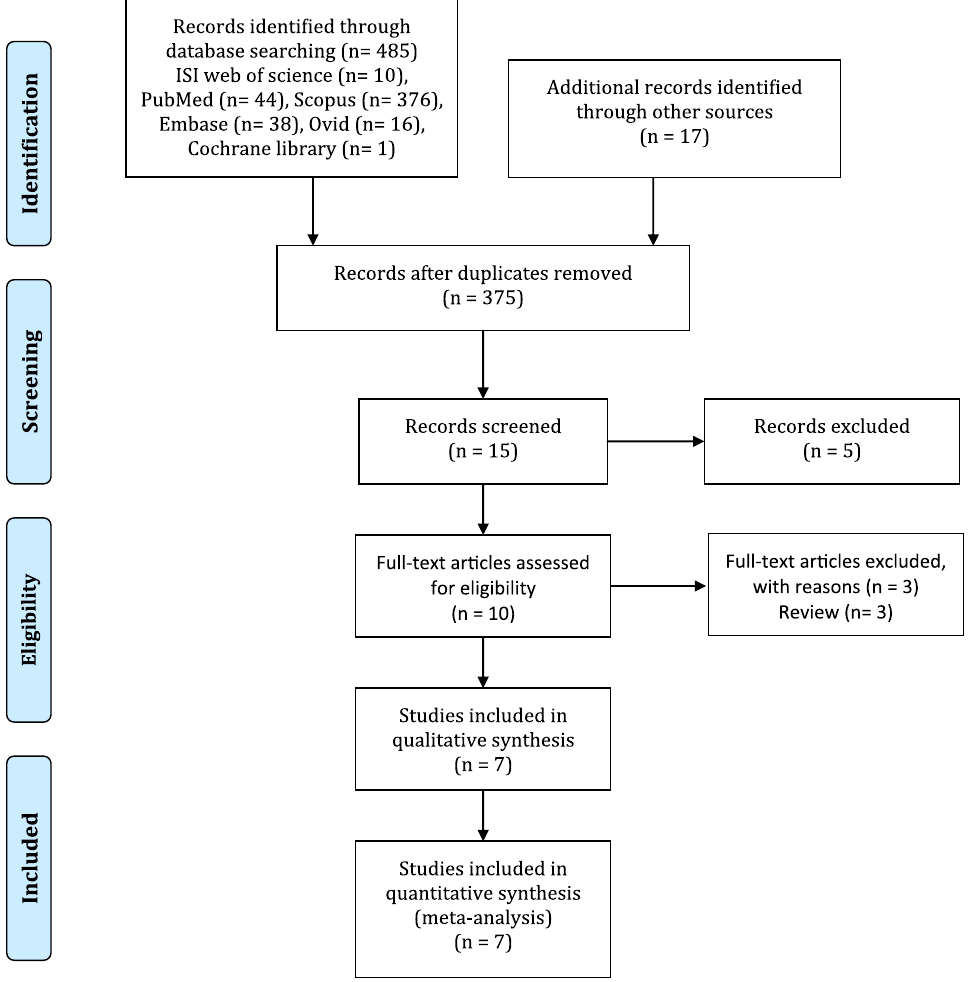
MCI, AD, frontotemporal dementia, and dementia of Lewy body PET scan patterns 18F-florbetaben PET transaxial images of healthy control (HC), patients with Parkinson’s disease (PD), dementia with Lewy bodies (DLB), MCI, AD, frontotemporal lobar degeneration (FTLD), and vascular dementia (VaD) were analyzed. AD patients show cortical 18F-florbetaben uptake and non-specific white matter uptake visible in negative scans of HC, PD, FTLD, and VaD. Sagittal and coronal amyloid PET images in AD patients demon- strate generalized increased activity within the cortical gray matter in all lobes with complete loss of